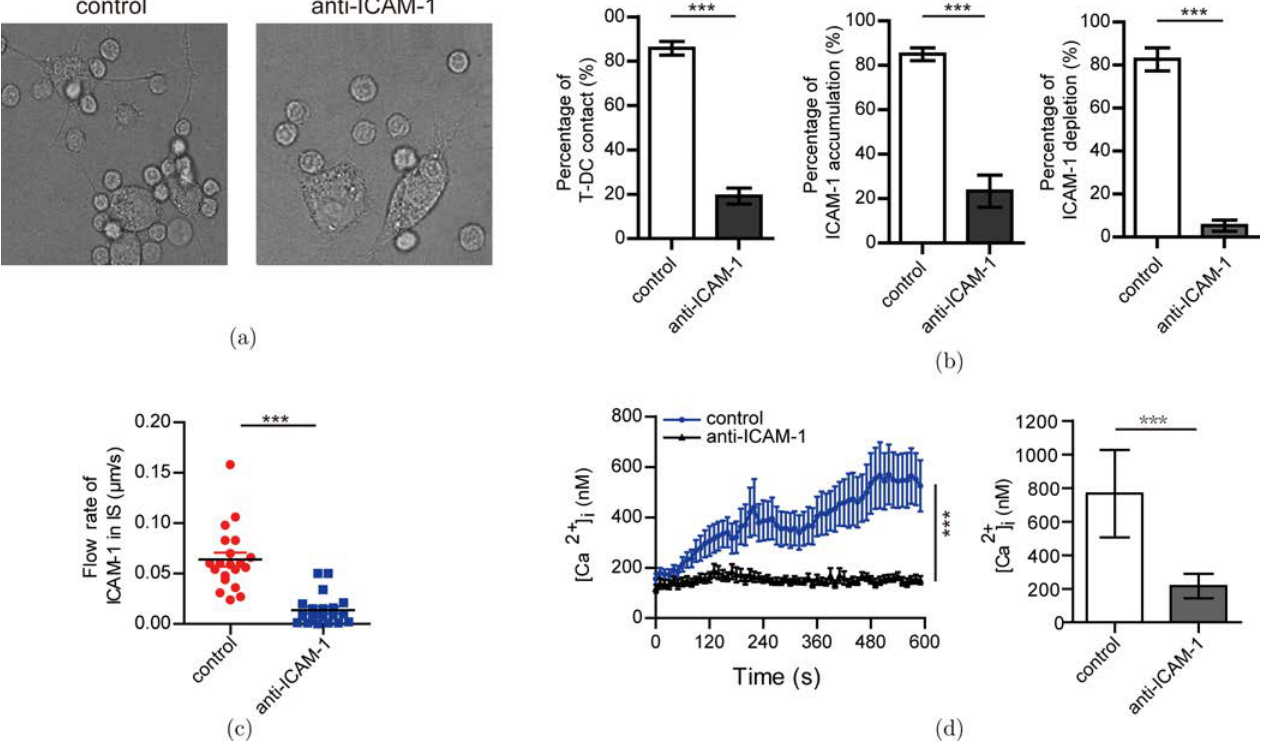
Fig. 4. Blocking ICAM-1 inhibited the accumulation of ICAM-1 in ISs and calcium release in T-cells: (a) With/without anti-ICAM-1 antibody treatment, the contact of T-DC was imaged, Bar ¼ 10 (cid:2) m. (b) With/without anti-ICAM-1 antibody treatment, the percentages of T-DC contact, ICAM-1 accumulation in the IS and ICAM-1 depletion in the IS. (c) The °ow rate of ICAM-1 in the synapses with/without anti-ICAM-1 antibody treatment. (mean (cid:4) s.e.m., n ¼ 20, three independent experi- ments), *** p < 0 : 001 (two-tailed Student's t -test). (d) With/without anti-ICAM-1 antibody treatment, the calcium release in T cells contacting DCs was measured. (mean (cid:4) s.e.m., n ¼ 20, three independent experiments), *** p < 0 : 001 (two-tailed Student's t